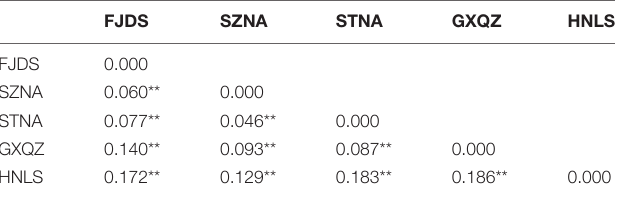
TABLE 3 | Pairwise Fst values between five noble scallop populations based on 10 microsatellite loci.